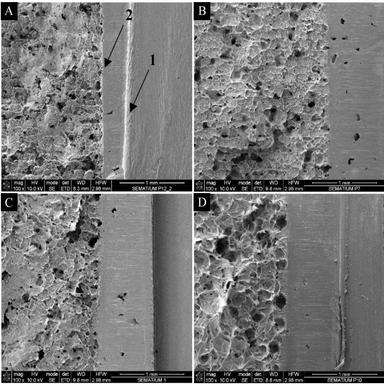
SEM images showing the morphology of the cracked region of SLS test specimens produced with EDV of (A) 0.158 (B) 0.198 (C) 0.278 (D) 0.358 J/mm3 .